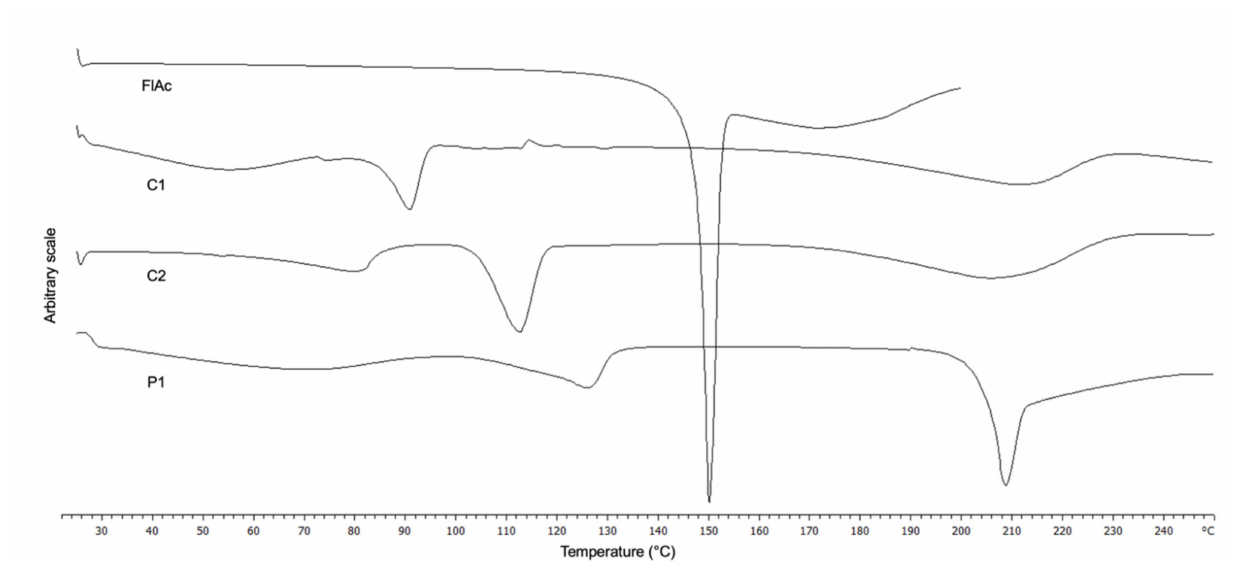
Figure 2. Differential scanning calorimetry curves of flecainide acetate (FlAc) and its different solid forms isolated from buffered solutions (C1 obtained from F5; C2 from F6; P1 from